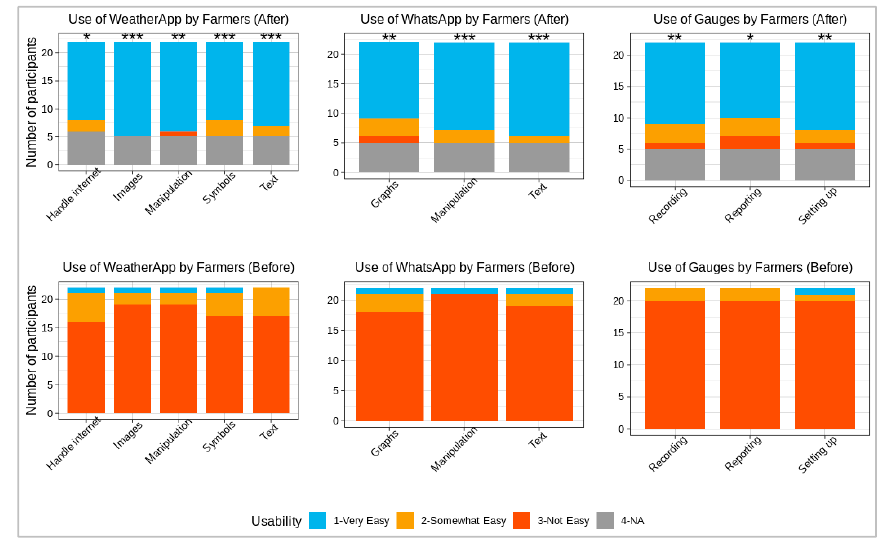
Figure 7. Usability of the digital and rain monitoring tools throughout the testing phase. “Not applicable (NA)” indicates participants who did not answer or dropped out of the experiment. Asterisks (*, **, and ***) indicate the significance of the results for the combined “somewhat and very easy” category at, respectively, p < 0.05, p < 0.01, and p < 0.001, based on a binomial distribution